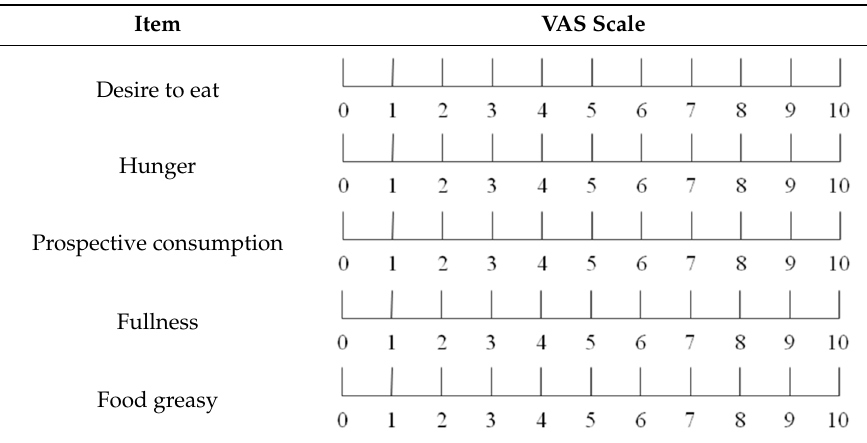
Table 4. The VAS questionnaire.